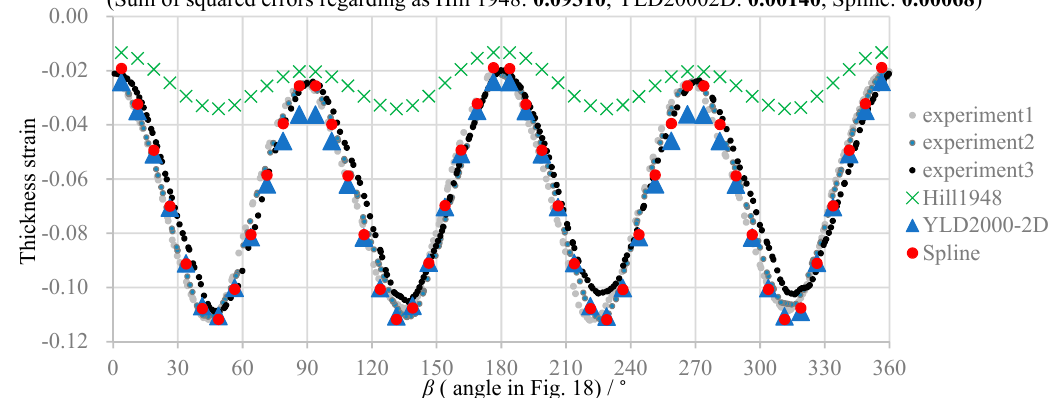
Figure 19. Comparison of thickness strain distributions on circle 1 in experimental condition A.